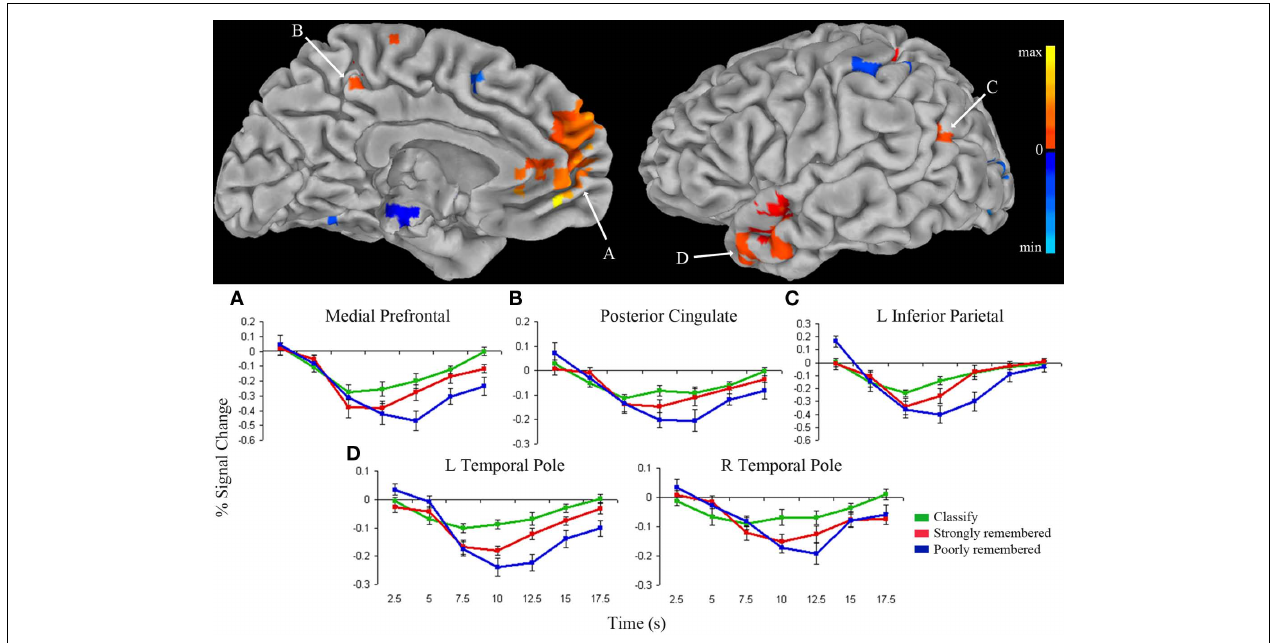
hippocampal impulse response model presented in Figure 3A .The average impulse response curves (bottom) from the medial prefrontal cortex (A) , posterior cingulate (B) , left inferior parietal cortex (C) , and left and right temporal pole (D) show decreased activity below fixation baseline for classify (green), followed by greater deactivation for strongly remembered (red), and greatest deactivation for poorly remembered